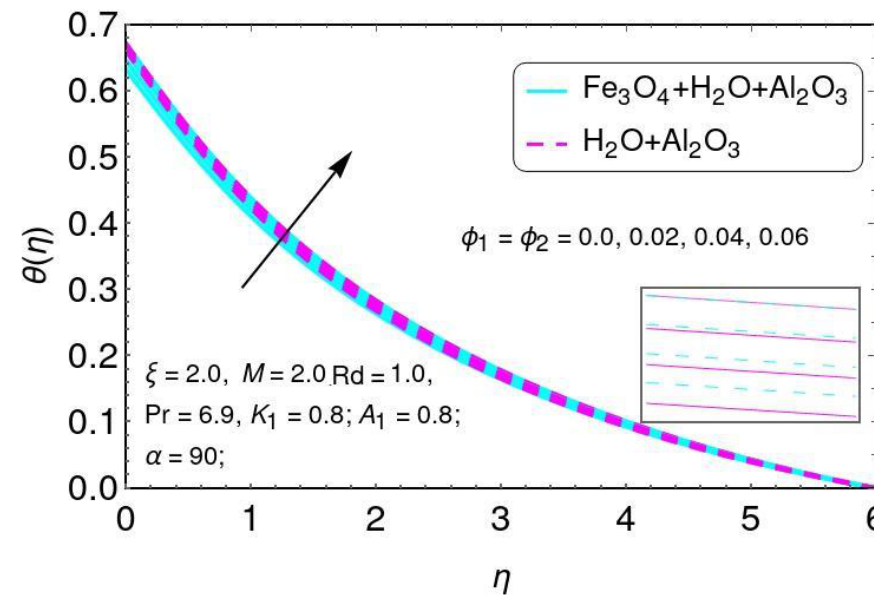
Figure 9. The characteristics of φ 1 , φ 2 on the temperature